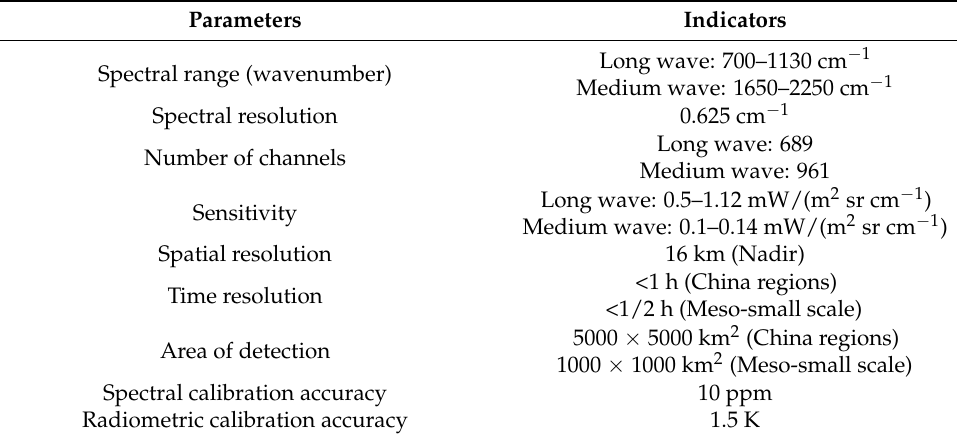
Table 1. FY-4A/GIIRS instrument performance parameters.